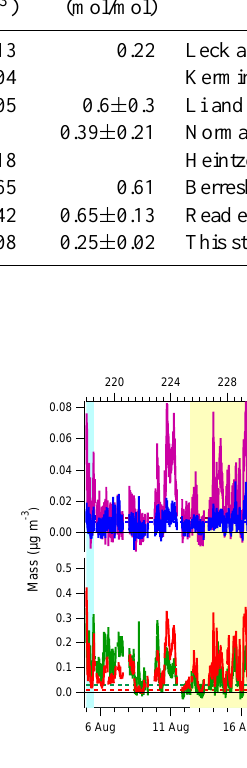
Table 2. Summertime sulphate and MSA concentrations at various polar locations. Location Sulphate